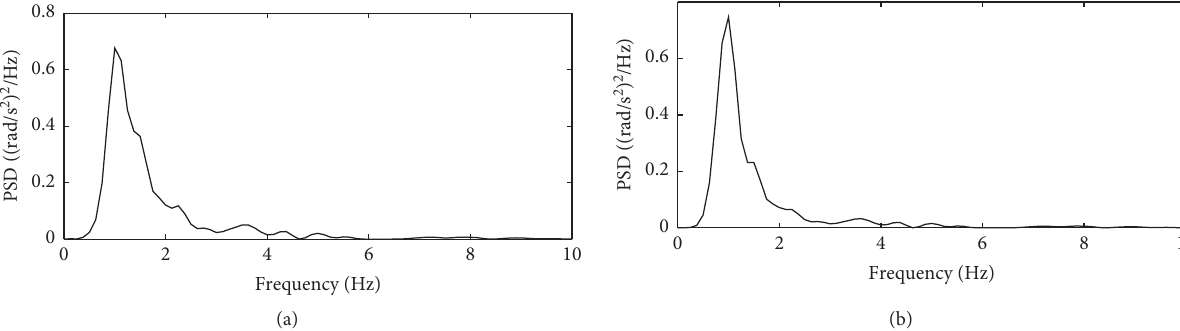
Figure 13: Roll response of upper human body under. (a) 4.7rad/s 2 r.m.s. roll vibration (equivalent with 1.4m/s 2 r.m.s. lateral excitation) and (b) 1.4m/s 2 r.m.s. lateral